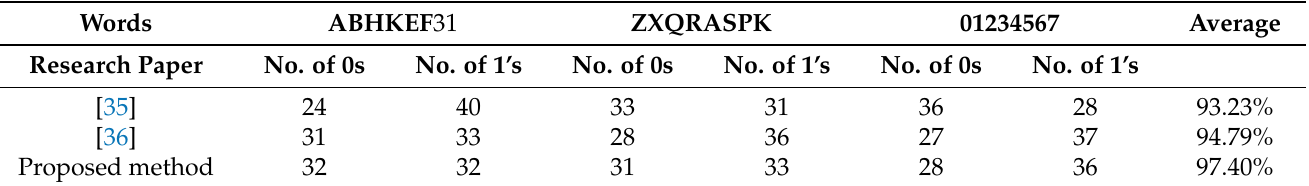
Table 6. Comparison of the output of balance criteria using the proposed S-Box generation technique and previous